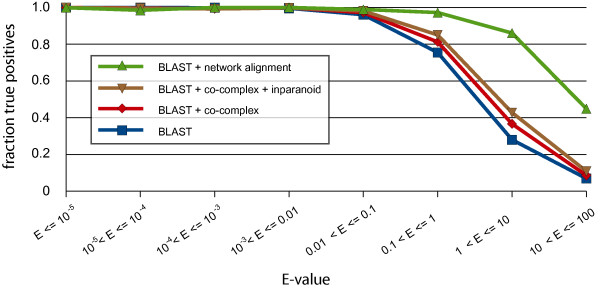
Fraction of True Positives for different E-value bins for different subsets of BLAST hits with that E-value. The fraction of True Positives for all BLAST hits ('BLAST', blue line), the BLAST hits for which both the human query as the yeast hit are part of a co-complex network ('BLAST+cocomplex', red line), the BLAST hits for which both the human query as the yeast hit are part of a co-complex network and both have a direct co-complex network neighbour that has a clear ortholog in the other species (is part of a human-yeast Inparanoid cluster) ('BLAST+cocomplex+inparanoid', brown line), the BLAST hits for which both the human query as the yeast hit are part of a co-complex network and both have a direct co-complex network neighbour and these neighbours are clear orthologs of each other (are part of the same human-yeast Inparanoid cluster) ('BLAST+network alignment', green line).